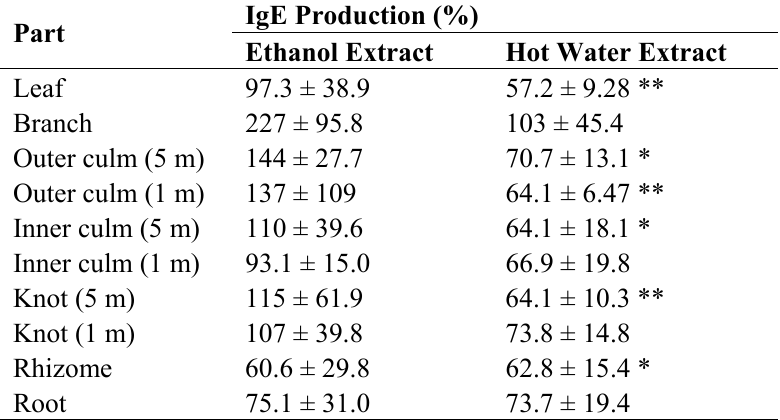
Table 4. Anti-allergy activity of the ethanol extracts and the hot water extracts of P. pubescens